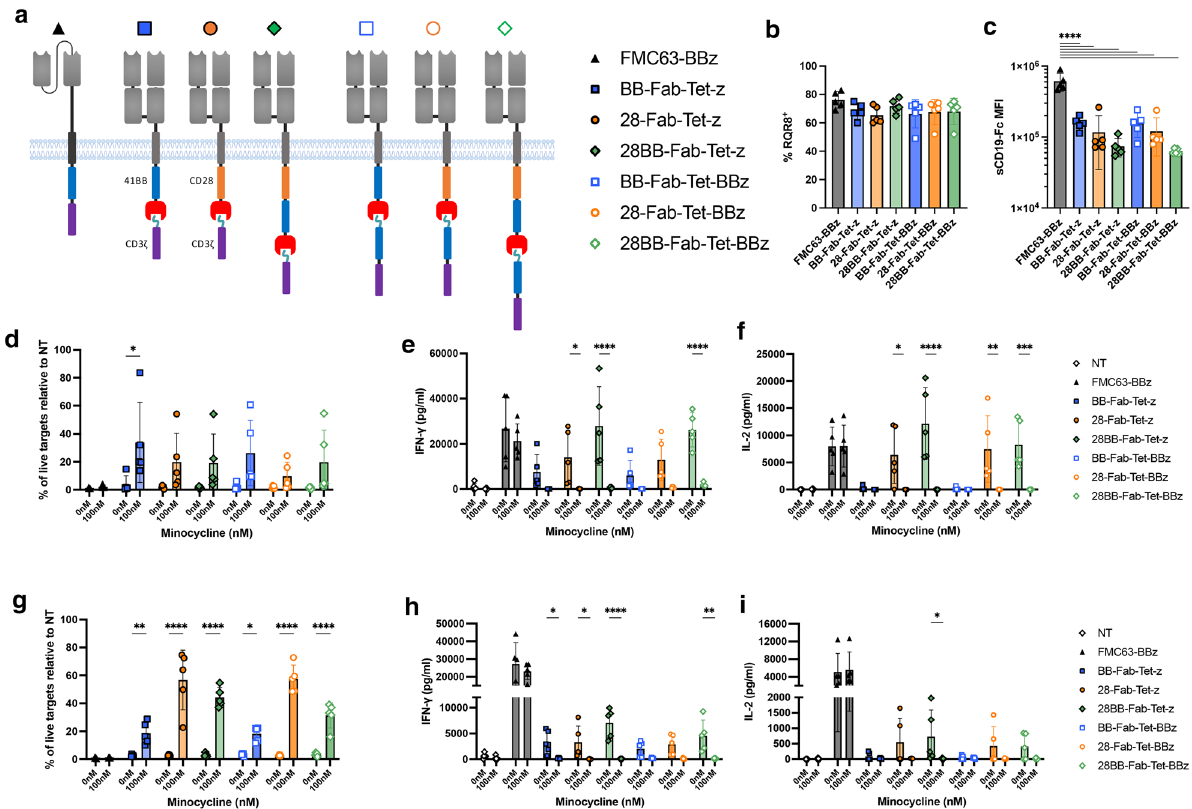
Figure 3. Reconfiguration of endodomain positions enhances TetCAR function. ( a ) Schematic overview of Fab-TetCAR constructs containing membrane-proximal 41BB or CD28 endodomains, with a TIP-CD3ζ or TIP-41BB-CD3ζ domains. ( b ) Transduction efficiency as measured by CD34 staining of the RQR8 marker gene. Data shows mean ± SD, n = 5 donors from 2 independent experiments. ( c ) Median fluorescent intensity of CAR expression on surface of RQR8 + cells as measured by staining with soluble, Fc-tagged CD19 protein. Data shows mean ± SD, n = 5 donors from 2 experiments. Statistical analysis was through one-way ANOVA between the groups, p values were; between FMC63-BBz and each Fab-TetCAR (****, < 0.0001). Differences between Fab- TetCARs alone were analyzed by one-way ANOVA but were not significant. ( d ) Killing of SupT1-CD19-GFP after 24 h co-culture with CAR-T cells at 1:1 E:T ratio. 100 nM of minocycline was added to relevant wells. Data shows mean ± SD, n = 5 donors from 2 independent experiments. Statistical analysis was through a two-way ANOVA comparing each group ± minocycline (with Šidák’s multiple comparisons). P values were; FMC-Tet-BBz (*, 0.0119). ( e ) IFN-γ and ( f ) IL-2 release after 24 h of co-culture with SupT1-CD19 at 1:1 E:T ratio (± 100 nM minocycline). Data shows mean ± SD, n = 5 donors from 2 independent experiments. Statistical analysis was through a 2-way ANOVA comparing each group ± minocycline (with Šidák’s multiple comparisons). P values for IFN-γ = 28-Tet-z (*, 0.0484), 28BB-Fab-Tet-z and 28BB-Fab-Tet-BBz (****, < 0.0001). P values for IL-2 = 28-Tet-z (*, 0.0150), 28BB-Fab-Tet-z (****, < 0.0001), 28-Fab-Tet-BBz (**, 0.0029) and 28BB-Fab-Tet-BBz (***, 0.0007). ( g ) Killing of NALM6 after 48 h co-culture with CAR-T cells at 1:1 E:T ratio. 100 nM of minocycline was added to relevant wells. Data shows mean ± SD, n = 5 donors from 2 independent experiments. Statistical analysis was through a two-way ANOVA comparing each group ± minocycline (with Šidák’s multiple comparisons). P values were; BB-Fab-Tet-z (**, 0.0083), BB-Fab-Tet-BBz (*, 0.0189) and 28-Fab-Tet-z, 28BB-Fab-Tet-z, 28-Fab-Tet-BBz and 28BB-Fab-Tet-BBz (****, < 0.0001). ( h ) IFN-γ and I) IL-2 release after 48 h of co-culture with NALM6 at 1:1 E:T ratio (± 100 nM minocycline). Data shows mean ± SD, n = 5 donors from 2 independent experiments. Statistical analysis was through a 2-way ANOVA comparing each group ± minocycline (with Šidák’s multiple comparisons). P values for IFN-γ = BB-Fab-Tet-z (*, 0.0433), 28-Fab-Tet-z (*, 0.0387), 28BB-Fab-Tet-z (****, < 0.0001) and 28BB-Fab-Tet-BBz (**, 0.0020). P values for IL-2 = 28BB-Fab-Tet-z (*,